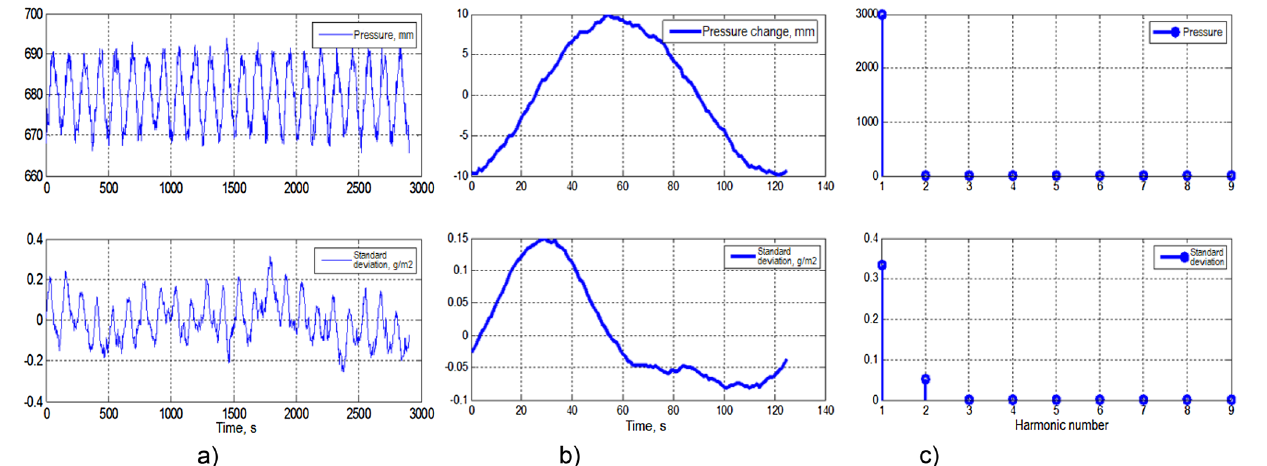
Fig. 4 Simulation results with an average value of the input signal equal to the optimal pressure (685 mm): (a) input harmonic and output noisy signals of an inertial extreme object; (b) results of syn-